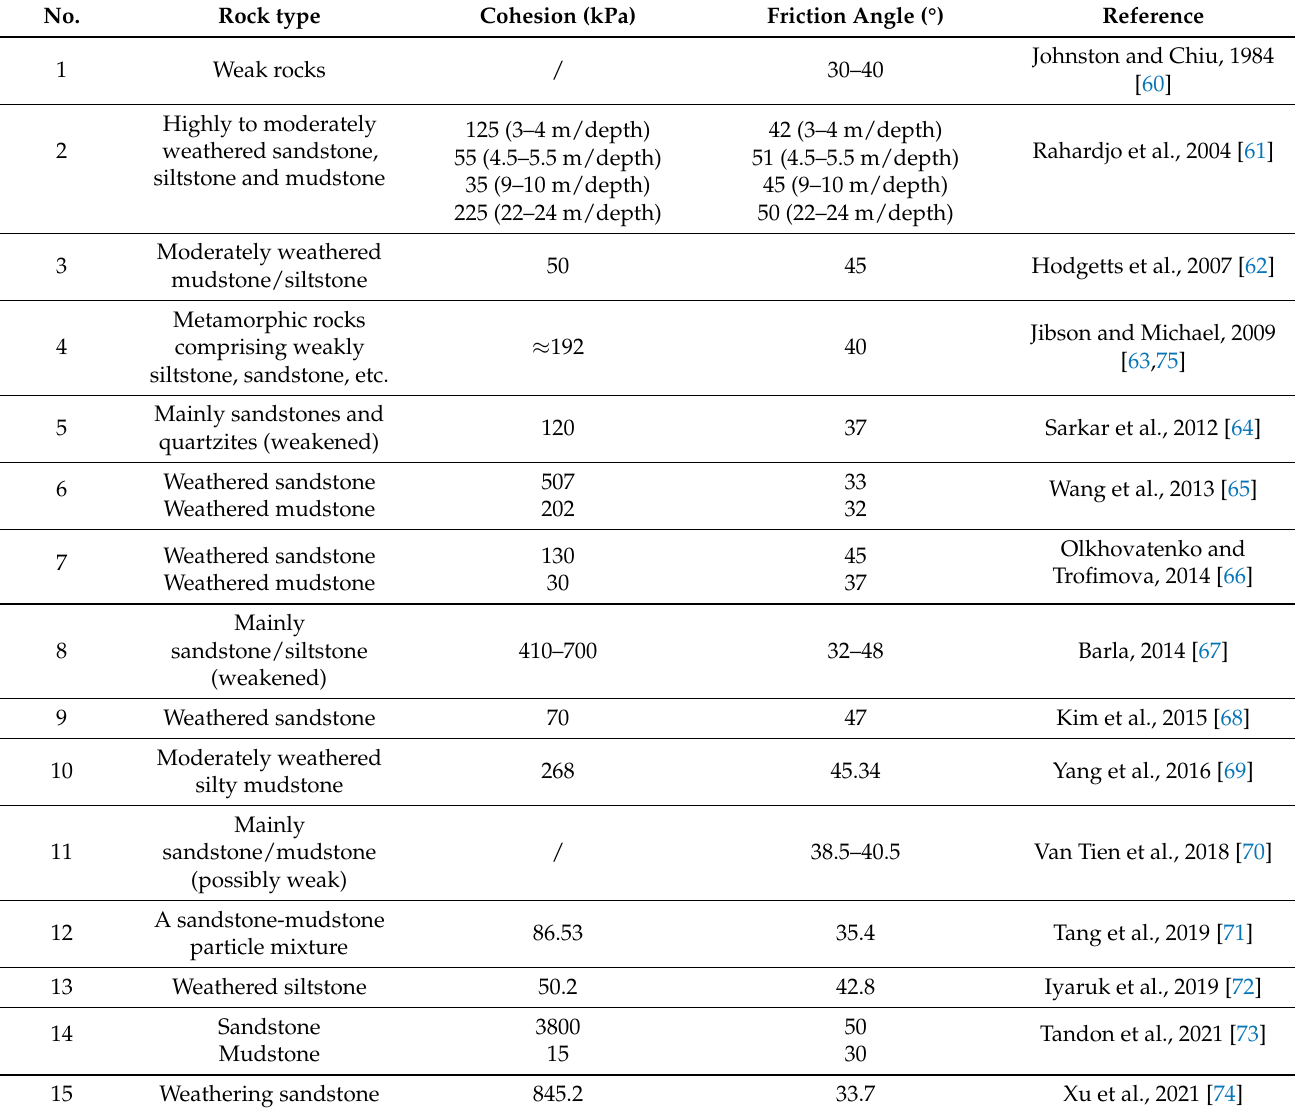
Table 3. Literature review of strength parameters (Mohr–Coulomb criterion) with similar geological composition (sorted by year of